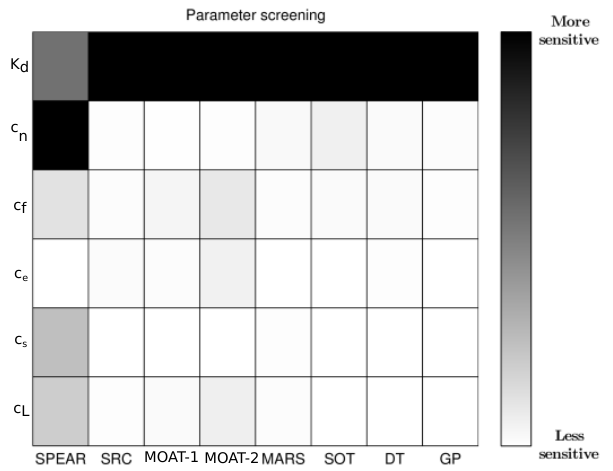
Figure 3. Comparison of the relative sensitivity of a subset of the parameters of the Canadian Small Lake Model, using the Mean Av- erage Error to evaluate the